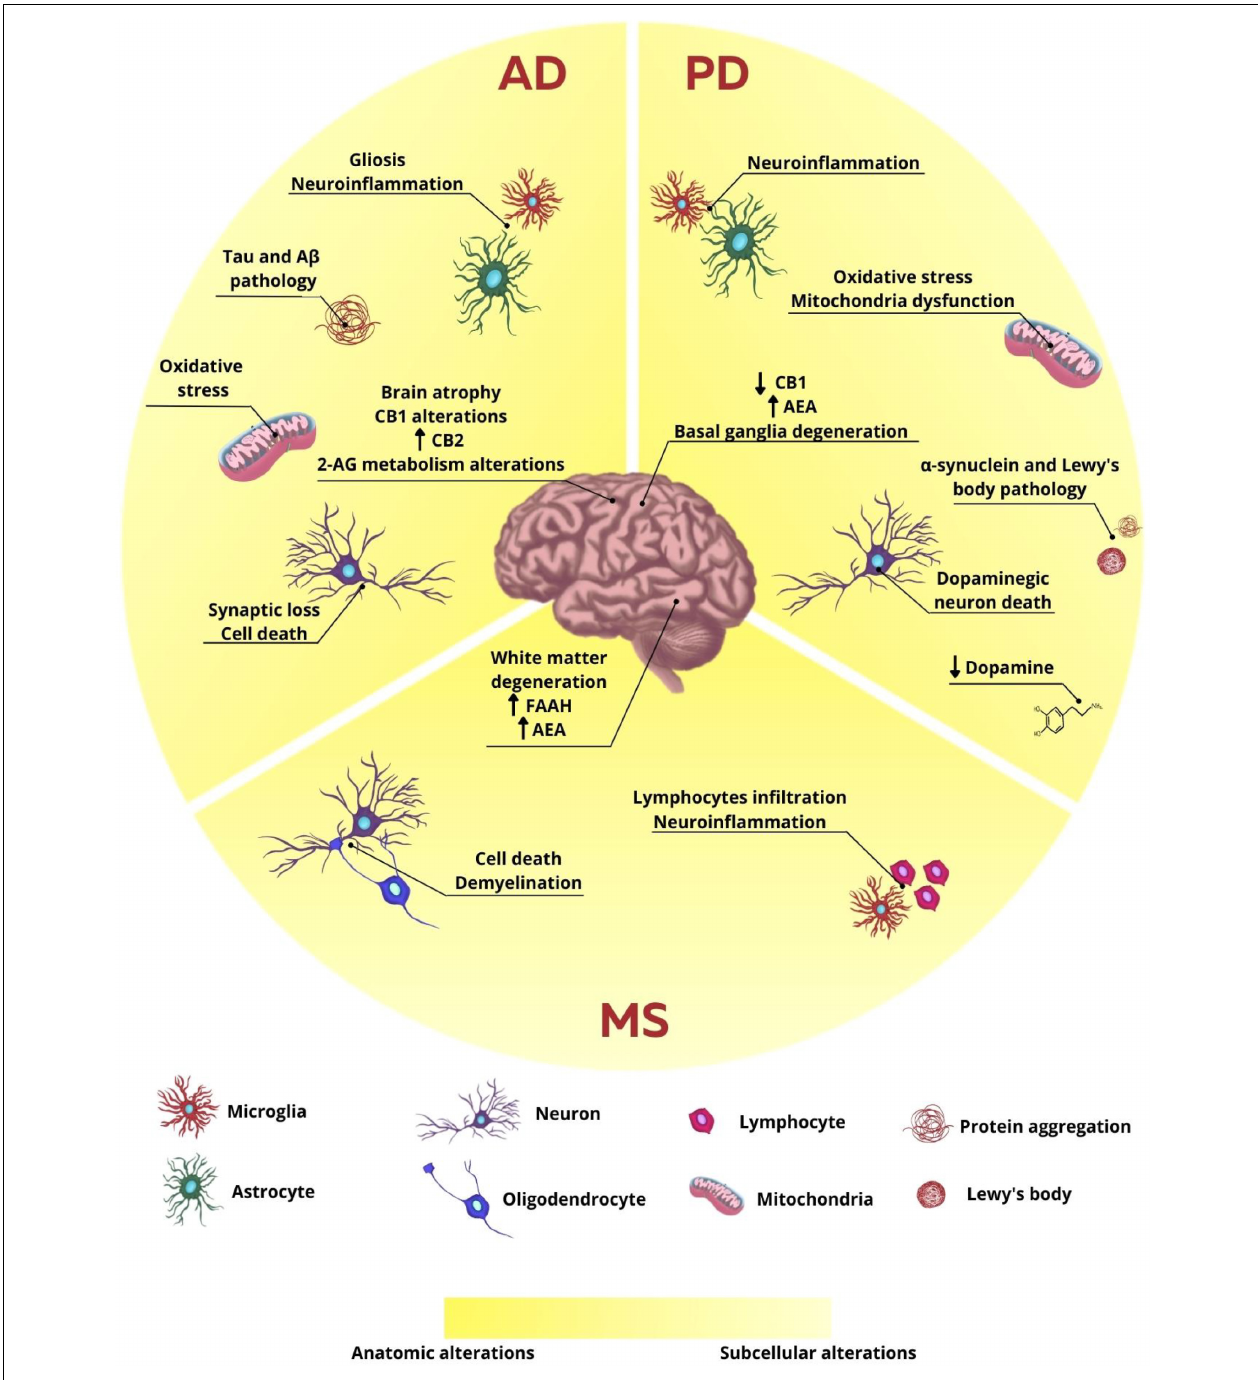
FIGURE 1 | Anatomic and subcellular alterations in neurodegenerative diseases. In AD, the characteristic subcellular alteration is the intracellular aggregates formed by hyperphosphorylated tau protein and extracellular plaques of β -amyloid protein, neuroinflammation associated with gliosis, oxidative stress, synaptic loss, and cell death. The endocannabinoid system is also altered with alteration in CB1, CB2, and 2-AG expression and production, respectively. These cellular changes are related to brain atrophy observed in patients and animals. In PD, the main cellular observation is the loss of dopaminergic neurons and consequent decrease in dopamine release. There is also protein aggregation of α -synuclein and the formation of Lewy bodies, neuroinflammation, and oxidative stress, which leads to basal ganglia degeneration. CB1 expression is reduced and AEA levels are increased. In MS, however, neuroinflammation is the main characteristic of the disease, once lymphocytes infiltrate the brain and microglia reaction. There is also cell death and demyelination, leading to white matter degeneration. FAAH expression and AEA levels are increased.